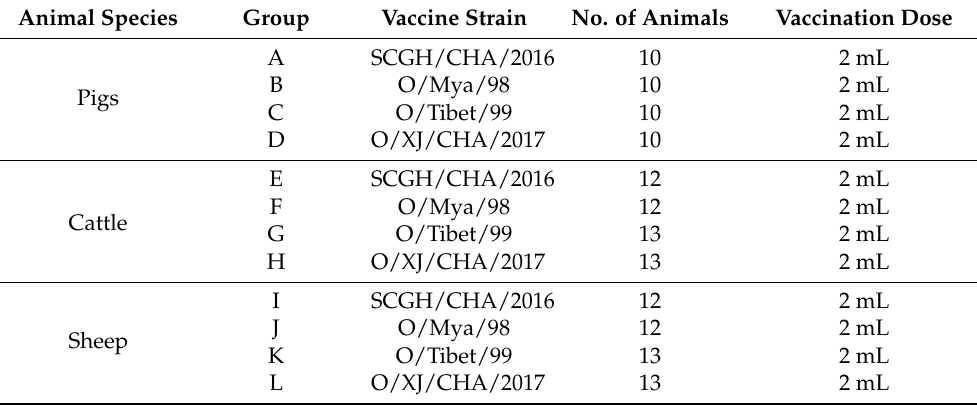
Table 1. Animal grouping and vaccine immunization. Animal Species Vaccine Strain No. of Animals Vaccination